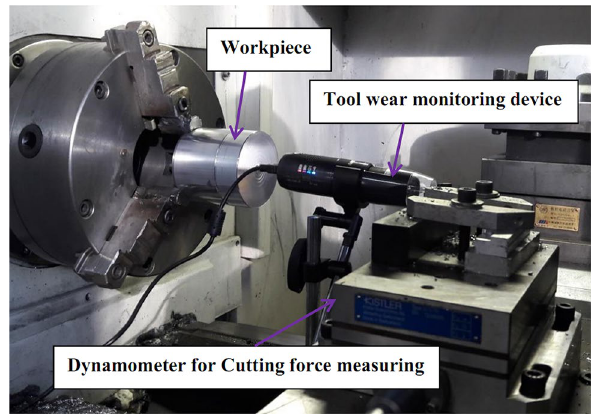
Fig. 1 Experimental